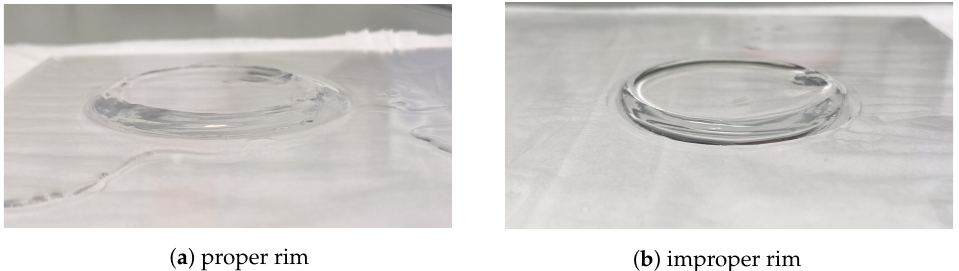
Figure 7. CD 2 foil formation. ( a ) The polymer gel with proper rim keeps its dimension during a drying process. ( b ) The polymer gel with improper rim can shrink to a much smaller size after drying out.